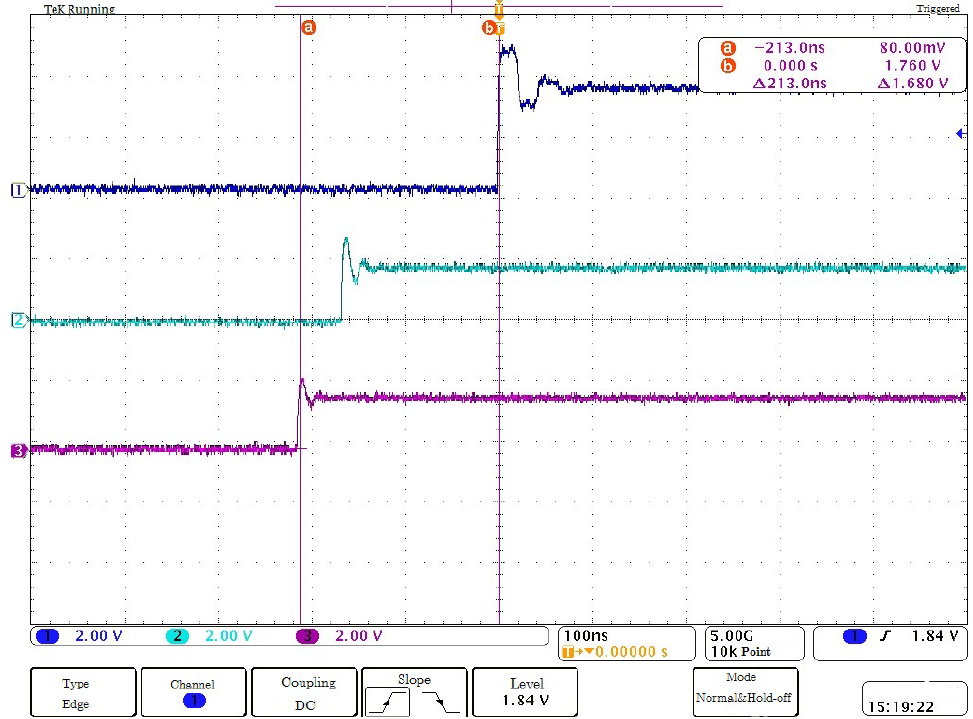
Figure 6. Synchronization accuracy examination of the data acquisition stations.